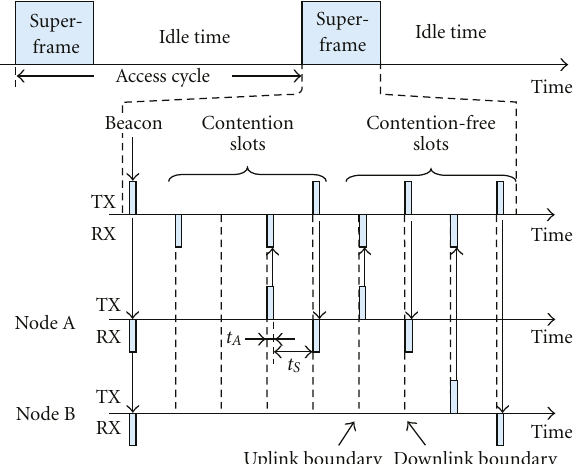
Figure 2: TUTWSN access cycle and